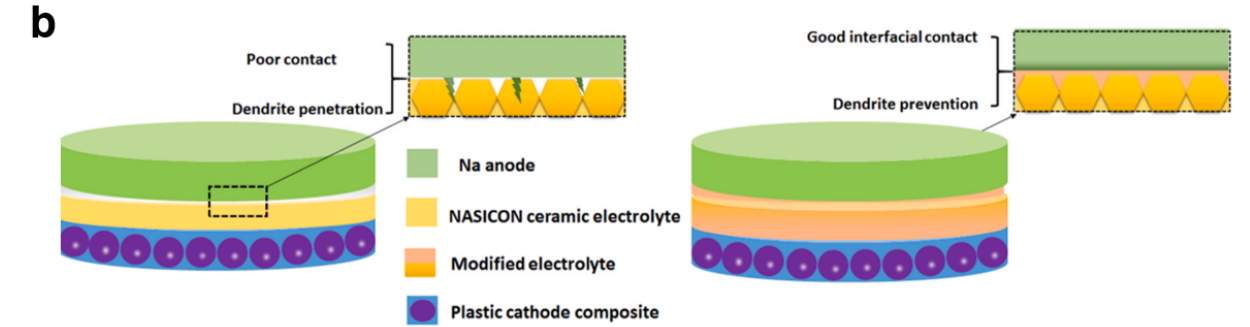
Figure 6. ( a ) Schematic of the optimizing steps for the proposed composite SPE, reproduced with permission from Reference [52] Copyright 2021, Royal Society of Chemistry. ( b ) Illustration of the grain boundary engineered ceramic electrolyte depressing the Na dendrites in all-solid-state NMBs, reproduced with permission from Reference [118] Copyright 2021, Elsevier.